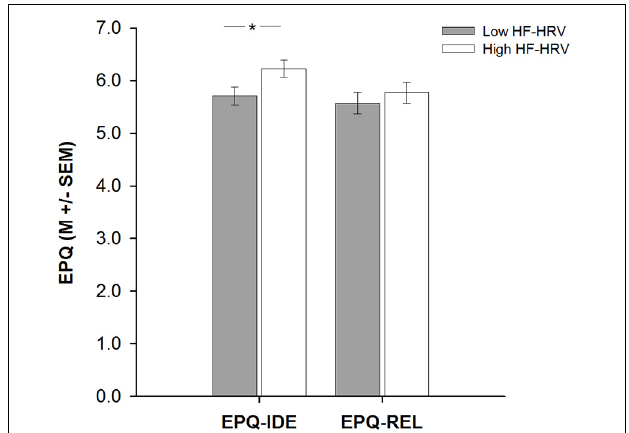
FIGURE 2 | Bar plots demonstrating differences in moral idealism (EPQ-IDE) or moral relativism (EPQ-REL) between individuals with lower and higher heart rate variability (HF-HRV). Bars represent M ± SEM. * p ≤ 0.05.